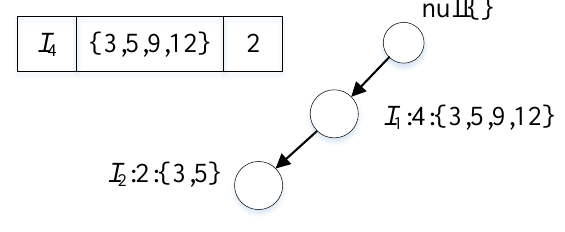
Figure 5. Condition tree of I 4